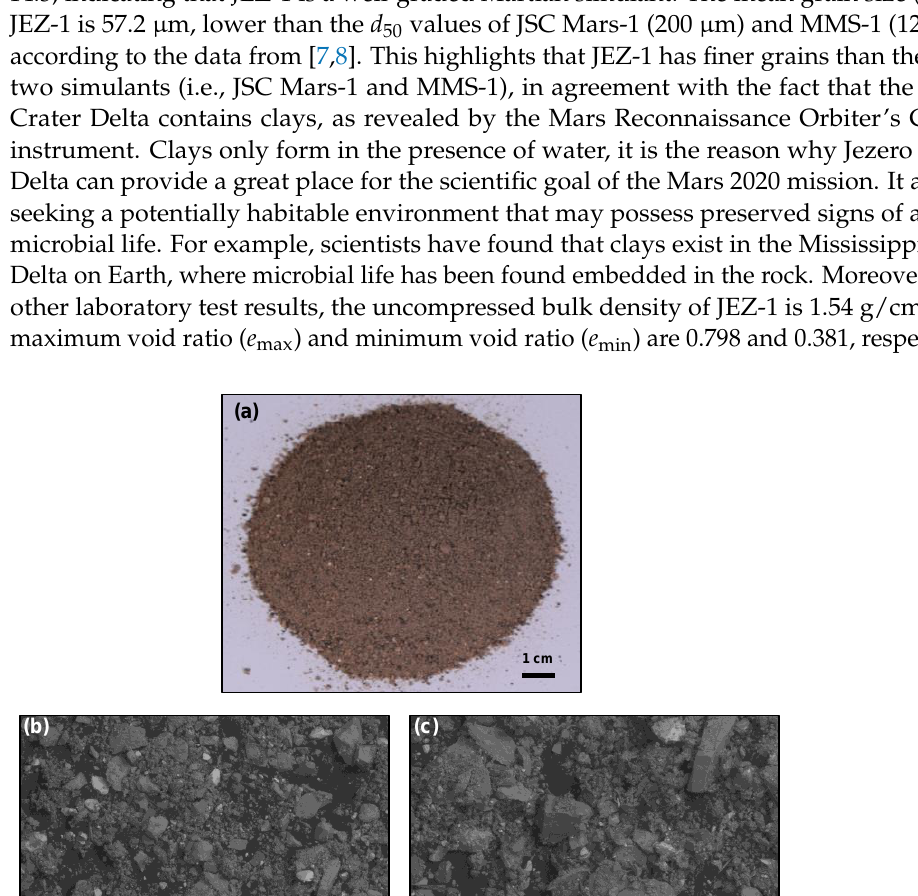
Table 2. Bulk major element chemistry of JEZ-1 (XRF results from Exolith Lab).